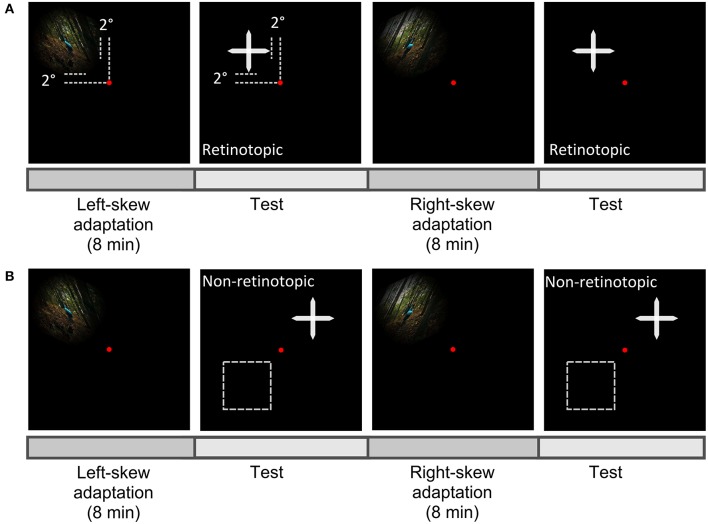
Scheme of experiment paradigm. Observers fixated centrally at the red dot and the aftereffect was measured in the upper-left visual field as the adapter in the retinotopic condition (A), or at a new location either in the upper-right or lower-left (the broken lines) visual field in the non-retinotopic condition (B).